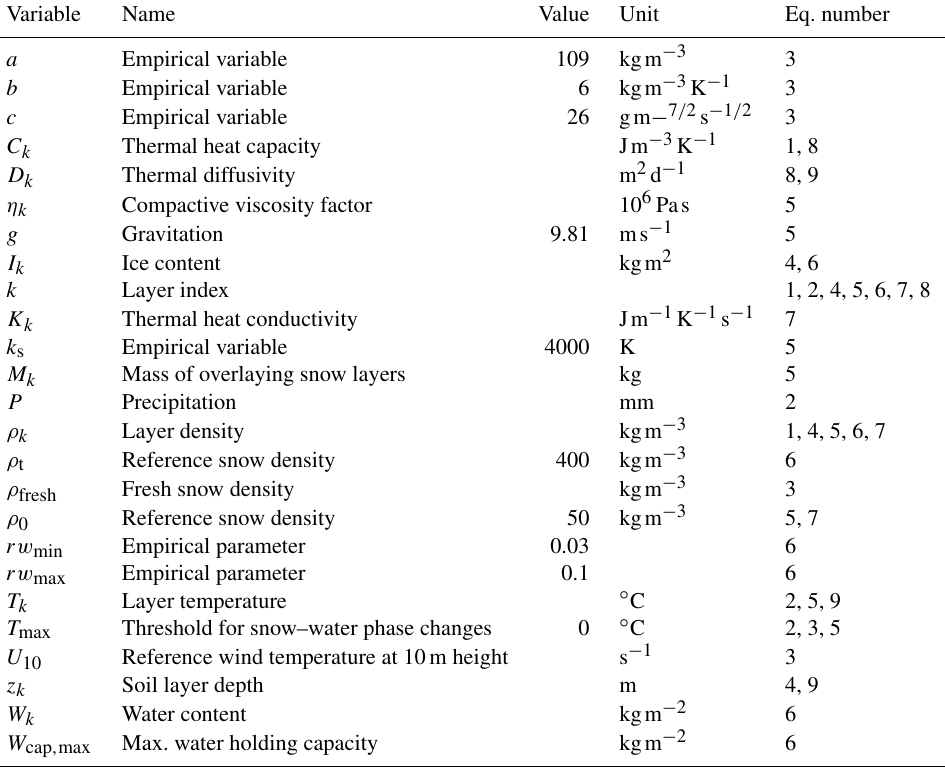
Table A1. Table with used variables, their description, and